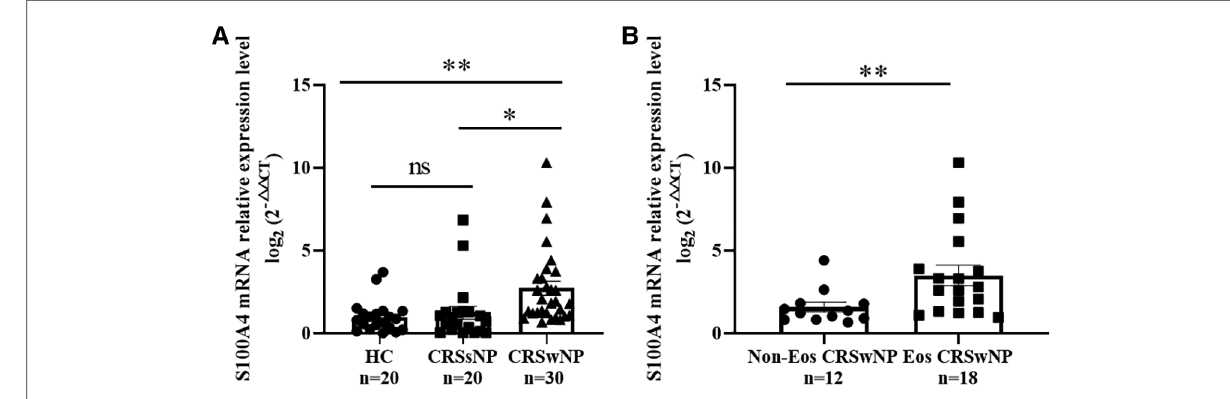
FIGURE 4 Comparison of S100A4 mRNA levels in the tissue of HC, CRSsNP and CRSwNP patients. ( A ) S100A4 mRNA expressions were elevated in the CRSwNP group than the HC group and the CRSsNP group, but no signi fi cant difference was observed between the HC group and the CRSsNP group. ( B ) S100A4 mRNA levels were signi fi cantly increased in the EOS CRSwNP group than the non-EOS CRSwNP group. * p <0.05, ** p <0.01, ns, no signi fi cance. Abbreviations: CRSwNP, chronic rhinosinusitis with nasal polyps; HC, healthy control; CRSsNP, chronic rhinosinusitis without